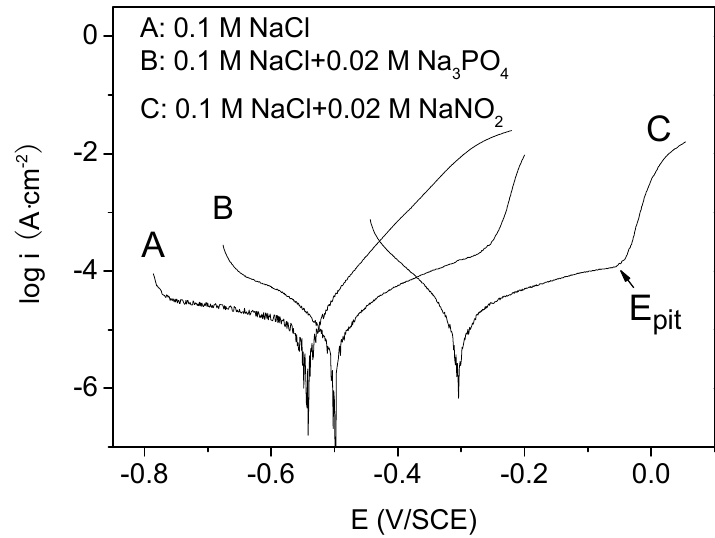
Figure 1. The Tafel curves of X70 carbon steel in various solutions (A) 0.10 mol/L NaCl; (B) 0.10 mol/L NaCl + 0.020 mol/L Na 3 PO 4 ; (C) 0.10 mol/L NaCl + 0.020 mol/L NaNO 2 .